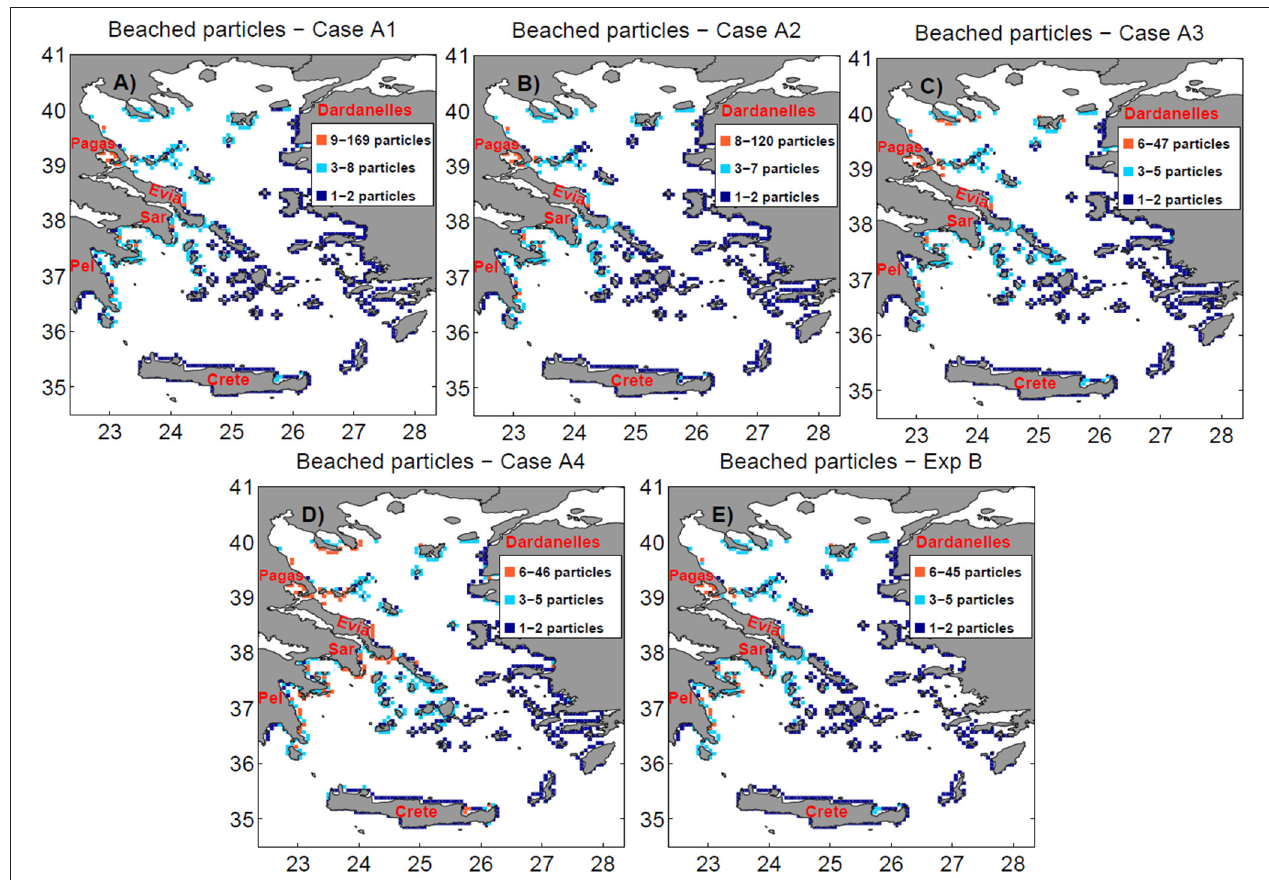
FIGURE 12 | Number of beached particles (count) in Cases (A) A1, (B) A2, (C) A3, (D) A4, and (E) Experiment B. A particle is considered as “beached” here if it drifted in cells adjacent to